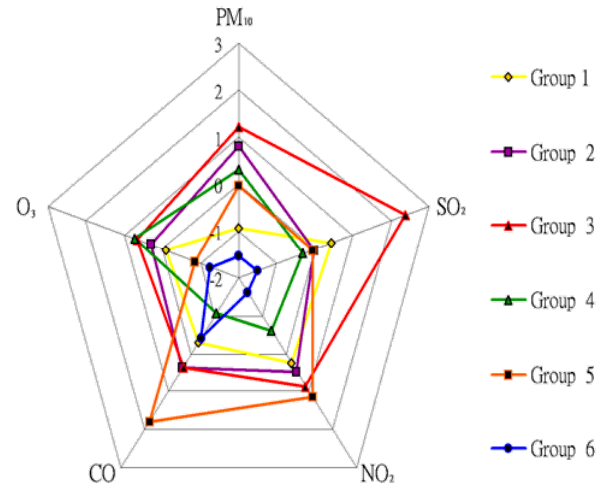
Figure 4: The air pollution characteristics of various groups.